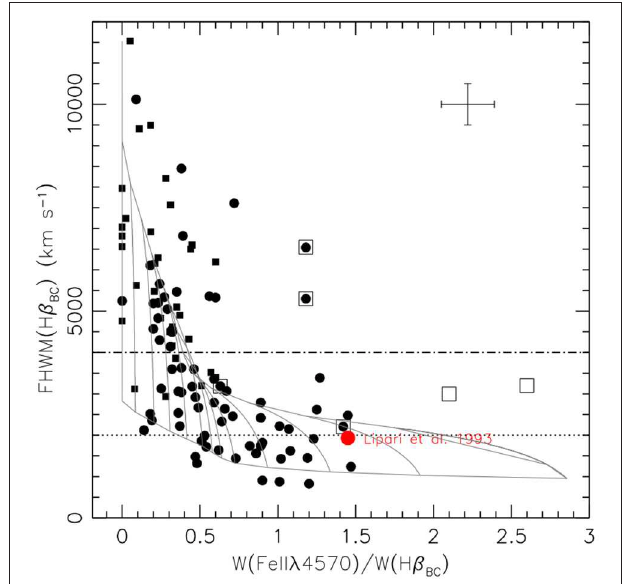
FIGURE 2 | Simplified version of Figure 4 in Marziani et al. (2001). The 4DE1 optical plane shows sources from the Sulentic et al. (2000b) sample with a superposed grid of theoretical values of viewing angle i (10 L / M BH , expressed in solar values, for 3.1 0), at steps of δ log L / M BH L / L Edd ≈ was assumed for U . Filled circles and squares represent RQ and RL sources, respectively. Boxes identify BAL QSOs (2 of them, Mark 231 and IRAS 0759 651 not in Sulentic et al., 2000b). The red spot mark the average for the + strong Fe II emitters of Lipari et al. (1993). Error bars in the upper right corner indicate typical 2 σ uncertainties for a data point at FWHM 0.5. The dot-dashed line is the FWHM( H β ) R FeII ≈ between Pop. A and B, and the dotted lines at FWHM( H β ) marks the FWHM limit of